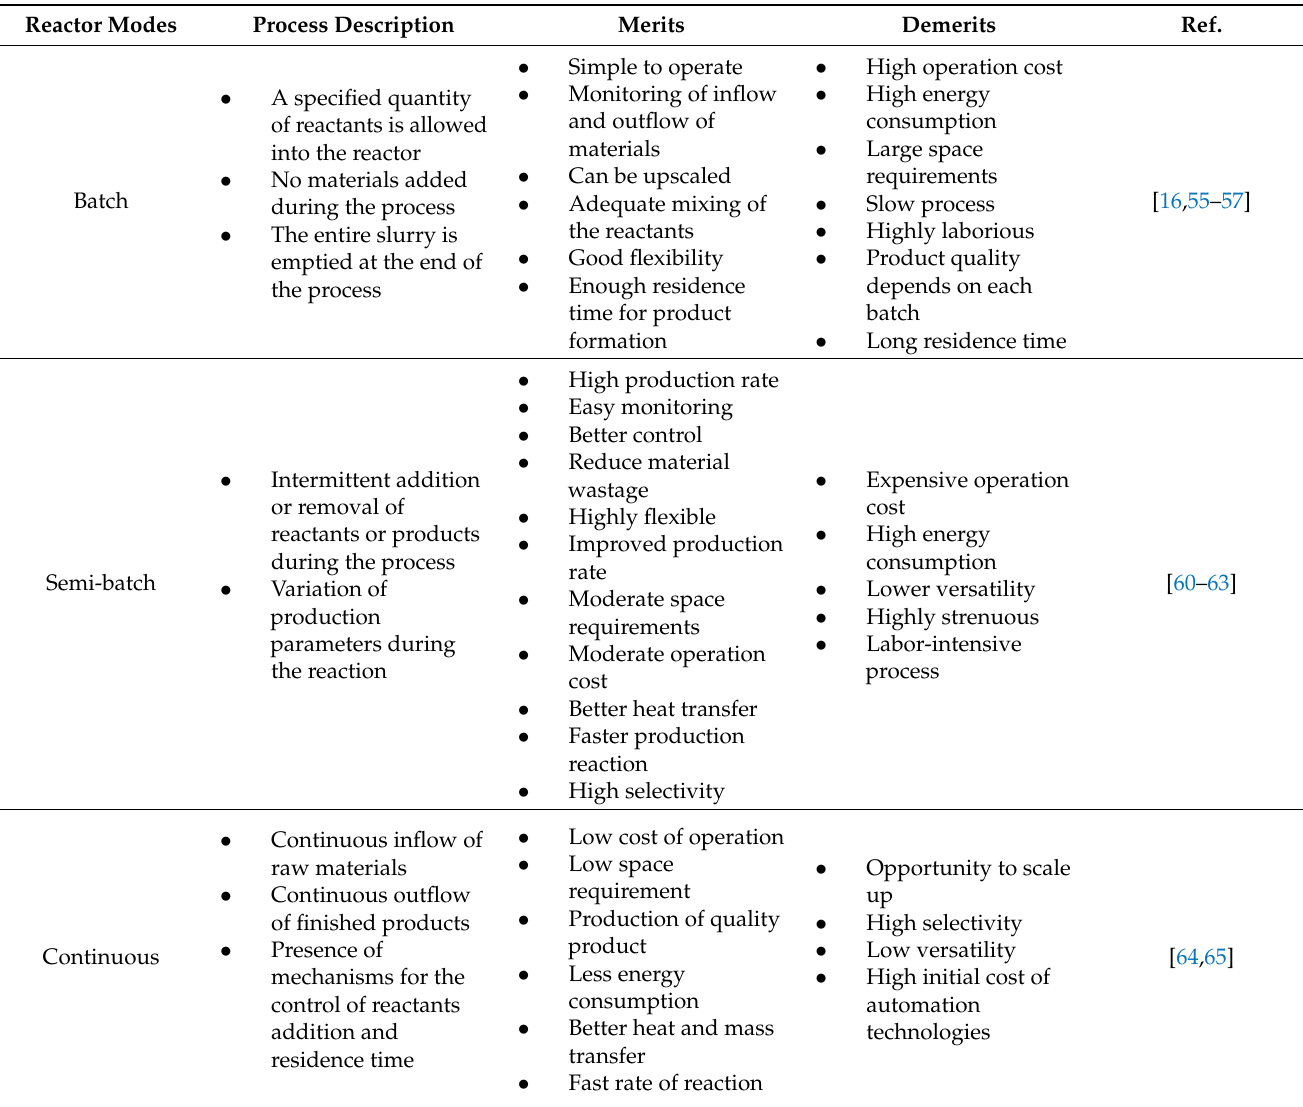
Table 5. Merits and demerits of batch, semi-batch, and continuous reactors. Reactor Modes Demerits